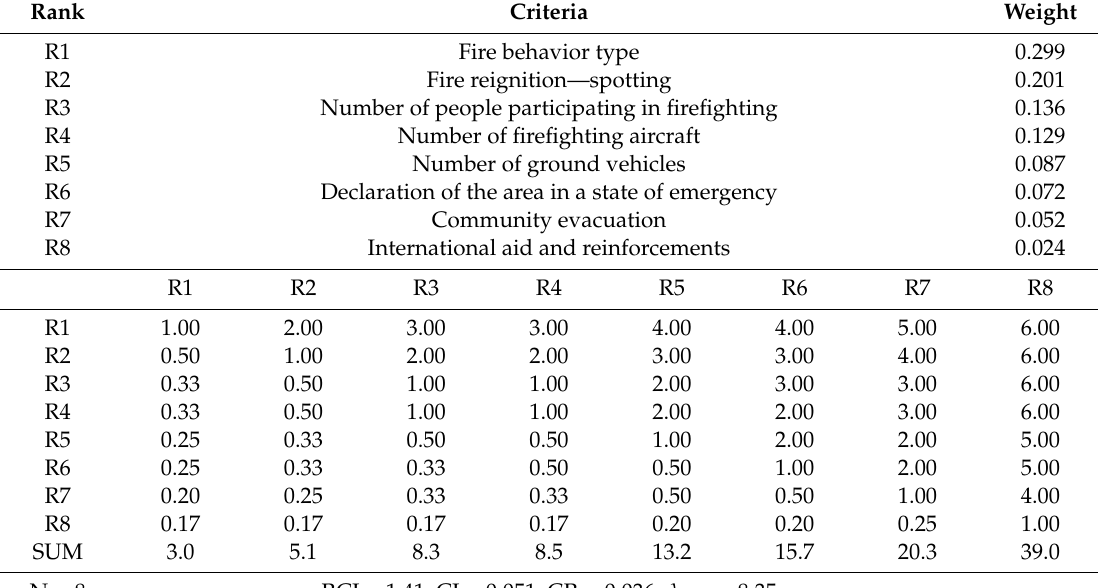
Table A11. Pair-wise comparison reciprocal matrix for the firefighting and wildfire suppression λ max : principal eigenvalue.